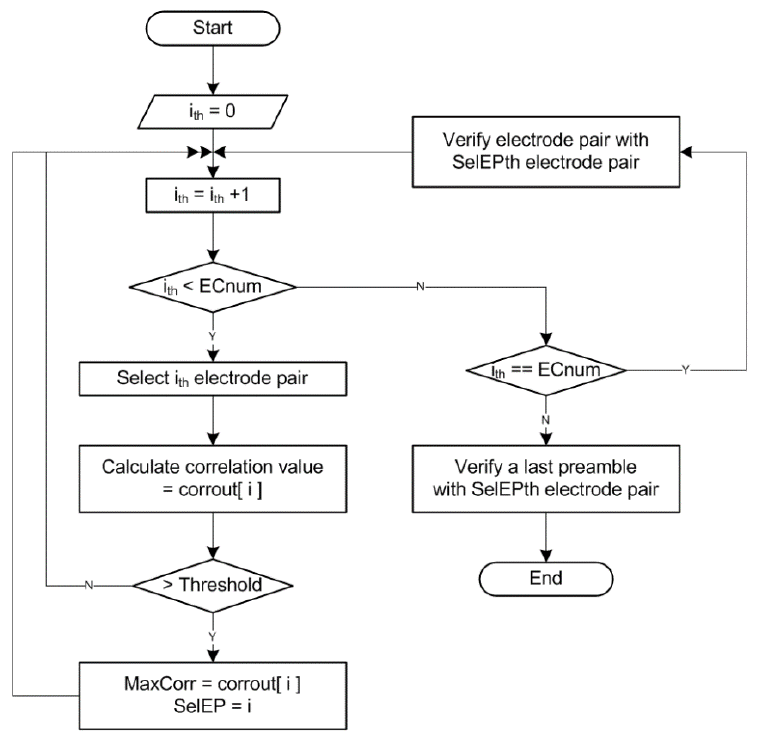
Figure 8. Flow chart of the electrode selection algorithm.